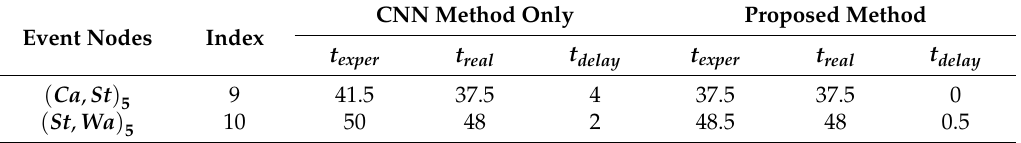
Figure 20. Graphs of < (cid:1849)(cid:1853), (cid:1829)(cid:1853) > (cid:2872) . Table 12. Basic SE of < (cid:1829)(cid:1853), (cid:1849)(cid:1853) > (cid:2873) .